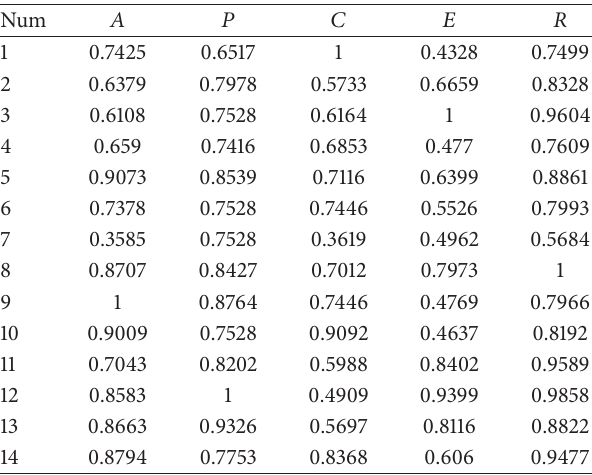
Table 6: Wheat seeds sorting evaluation